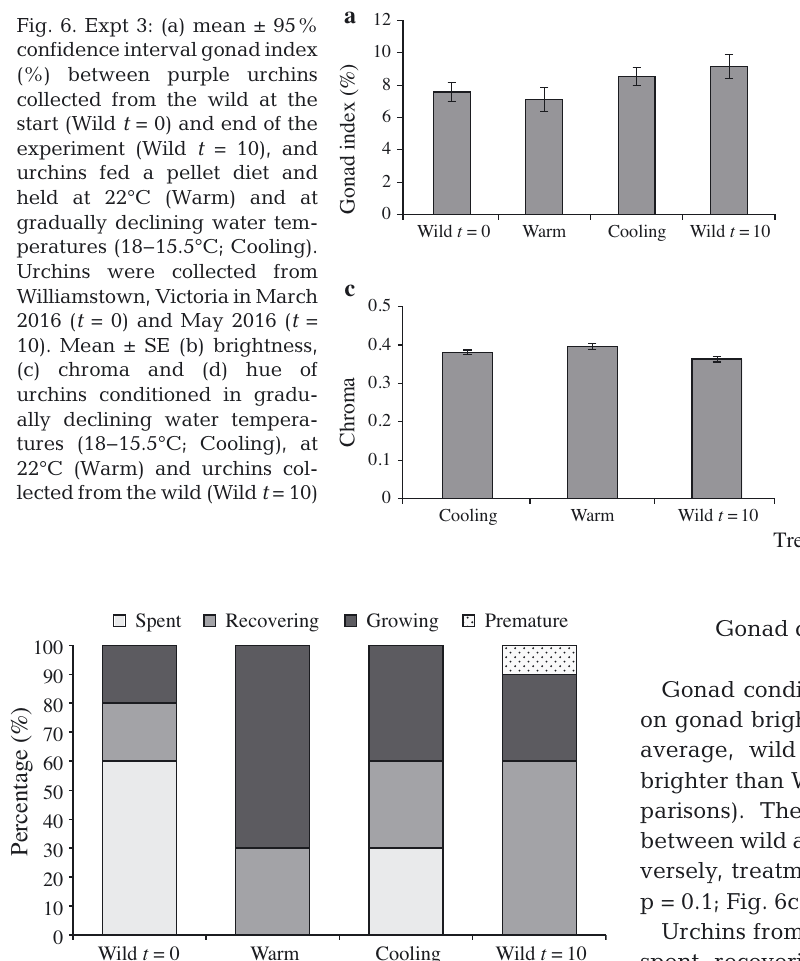
Fig. 7. Expt 3: percentage of purple urchins Heliocidaris ery- throgramma at different reproductive stages described by Laegdsgaard et al. (1991): spent, recovering, growing and premature. No sampled urchins were in the mature or partly-spawned reproductive stage. Purple urchins (n = 10) were sampled from Williamstown, Port Phillip Bay at the be- ginning of the experiment in March 2016 (Wild t = 0), after 12 wk of gonad conditioning at water temperatures mimick- ing seasonal decline (18−15.5°C; Cooling), after 12 wk of gonad conditioning at 22°C (Warm) and at the end of the experiment from the wild in May 2016 (Wild t =